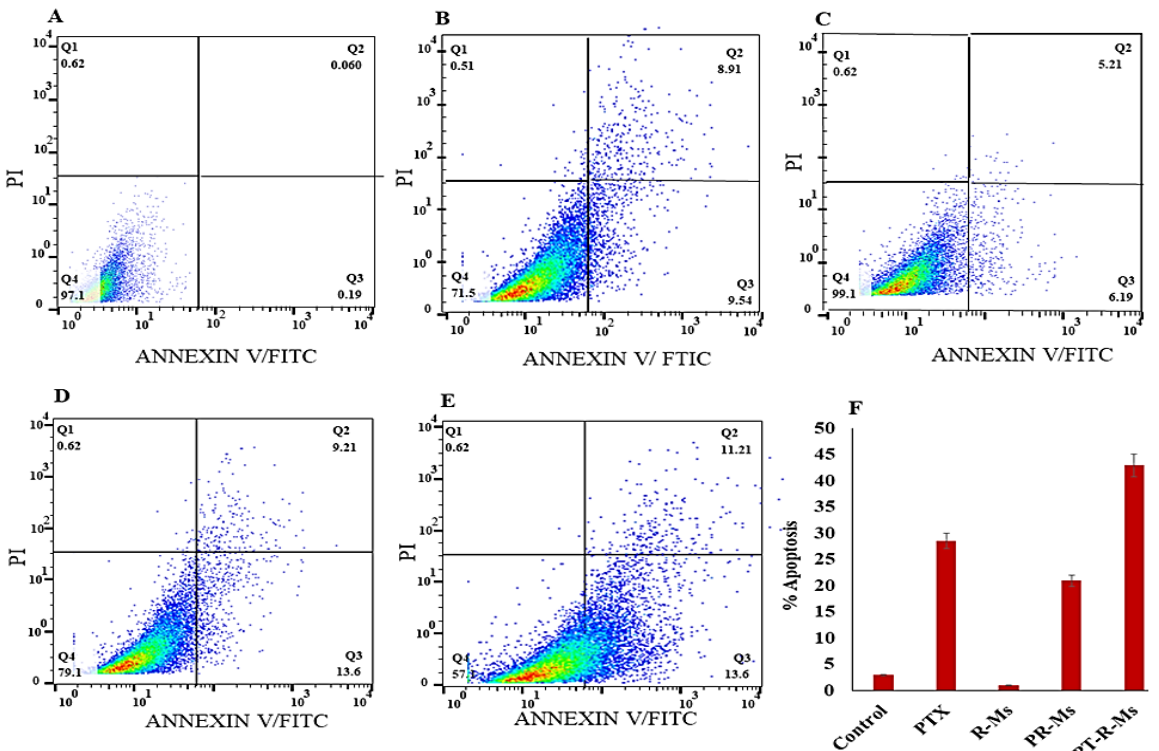
Figure 9. Apoptosis against HCT-116 cell lines induced by different formulations: ( A ) normal saline as control; ( B ) pure PTX; ( C ) R-Ms; ( D ) PR-Ms; ( E ) PT-R-Ms; ( F ) percentage of apoptosis in the pure drug and the different formulations. The results are obtained from three independent experiments. Data are shown as the mean ± SD ( n = 3) ( p < 0.05). HCT-116: human colorectal carcinoma cell line, R-Ms: redox micelles, P-RMs: papain functionalized redox micelles, P-RMs: papain functionalized thiolated redox micelles.